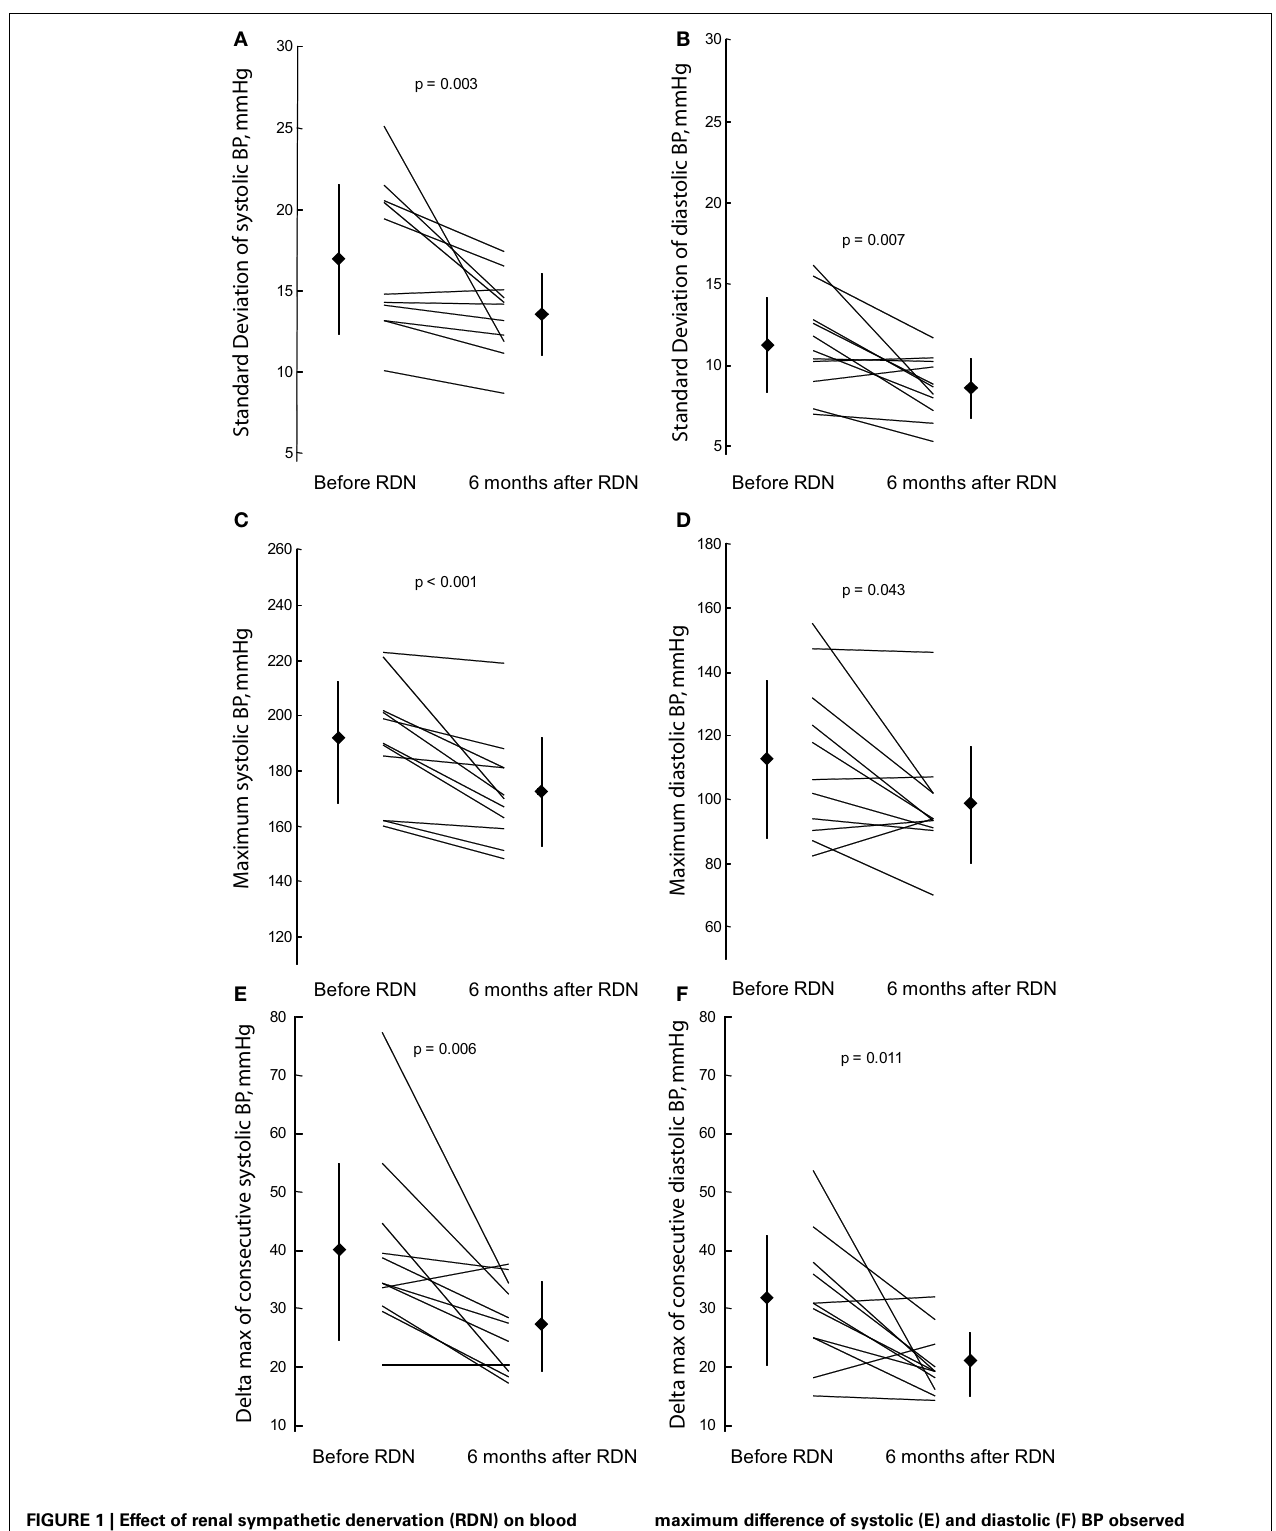
FIGURE 1 | Effect of renal sympathetic denervation (RDN) on blood pressure (BP) variability and instability: standard deviation of systolic (A) and diastolic (B) BP, maximum systolic (C) and diastolic (D) BP and